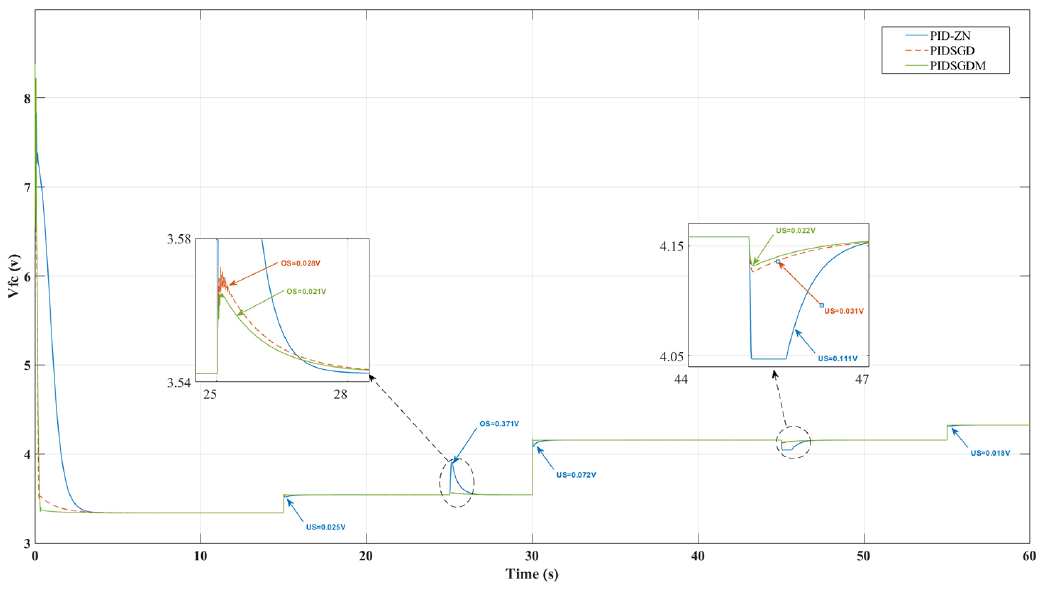
Figure 12. PEMFC stack output